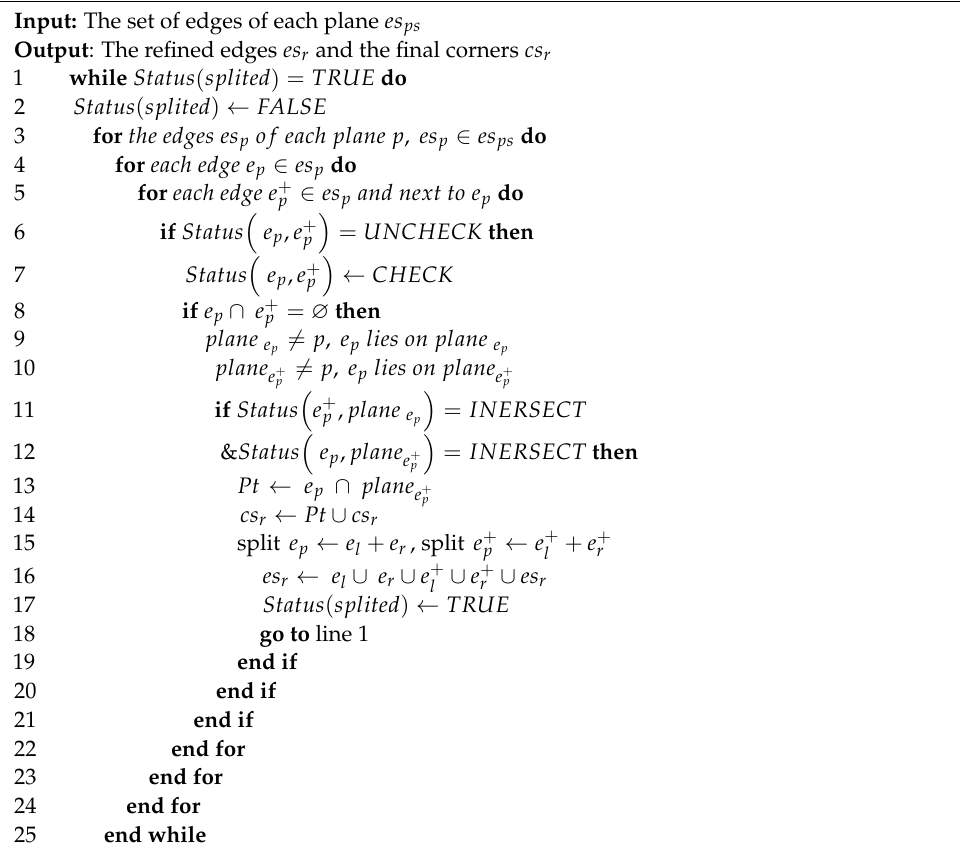
Figure 8. The split of line segments. ( a ) is the side view of a pair of line segments (labeled in black and gray) to be split. ( b ) is the top view of the line segments before splitting. After splitting, line segments were divided into four (labeled in different colors), and new corners (purple dot) and candidate faces (labeled in different colors) were formed in ( c , e ). ( d ) is the processed scaffold. ( e ) presents the 3D partitioning result divided by the candidate faces, where the top part is omitted. Algorithm 1. Refine